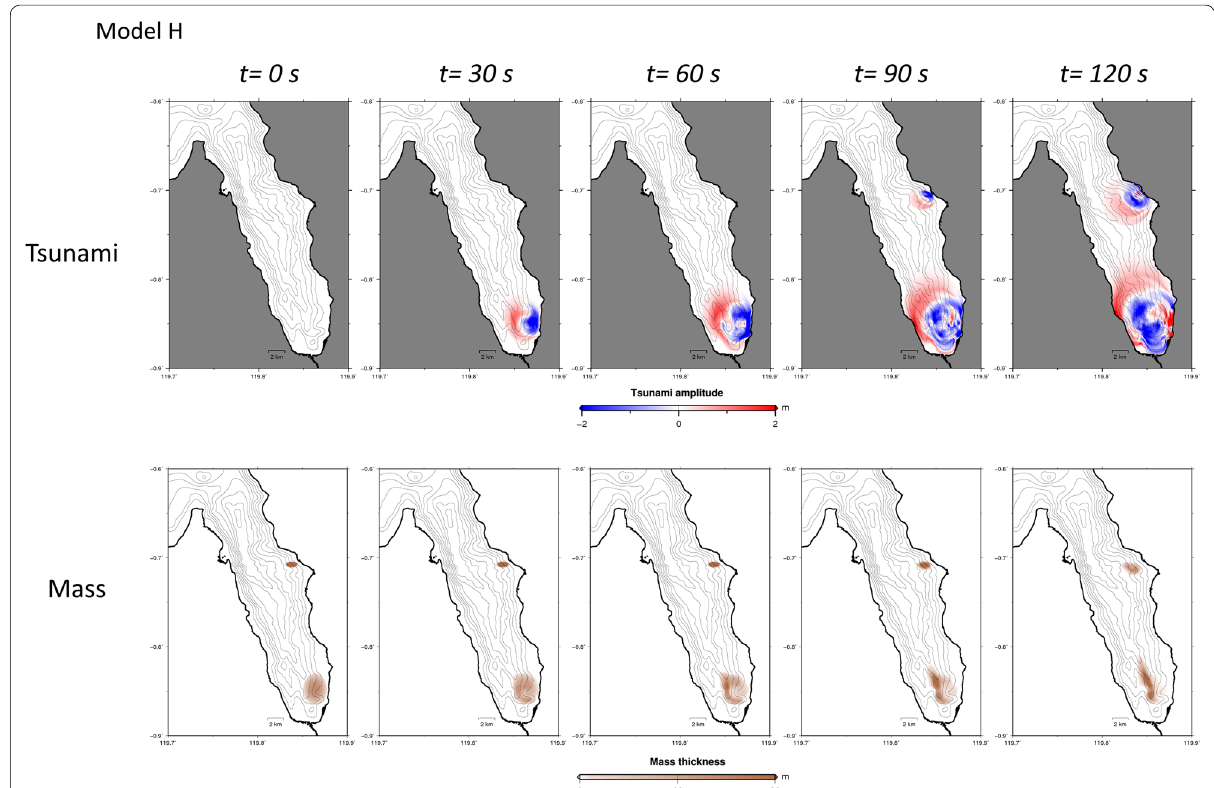
Fig. 10 Snapshot of tsunami propagation (upper figure) and mass motion (lower figure) for model